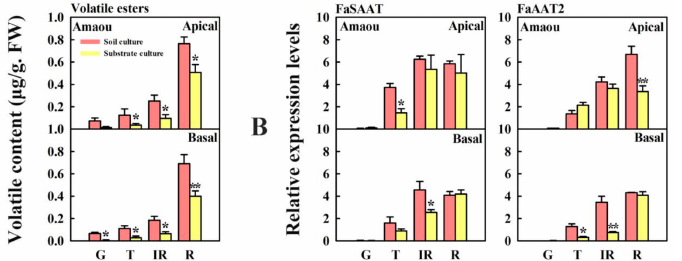
Figure 5. Changes in volatile esters ( A ) and expression of FaSAAT and FaAAT2 ( B ) in ‘Amaou’ strawberry. Bars stand for means ± SD from three biological replicates. Asterisks indicate significant differences (* 0.01 < p < 0.05; ** p <